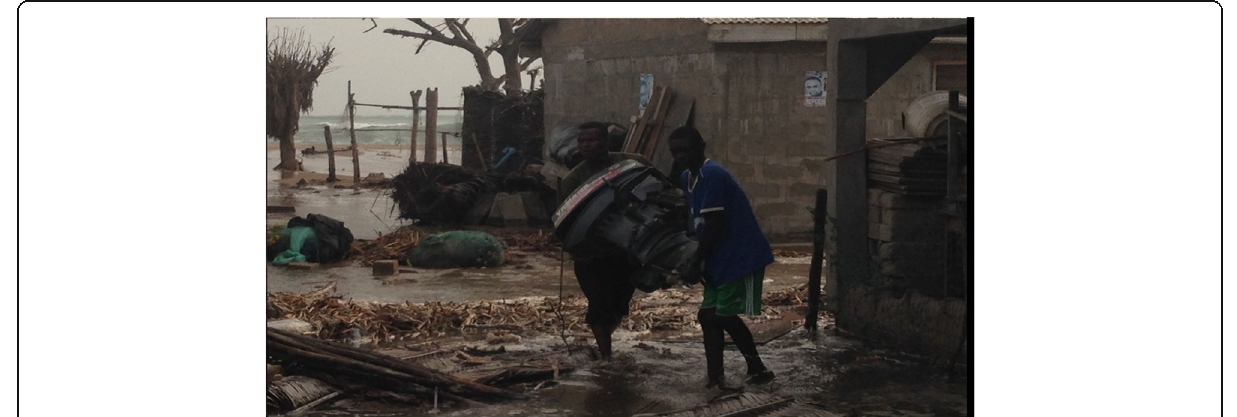
Fig. 10 Families carrying an outboard motor from a flooded house